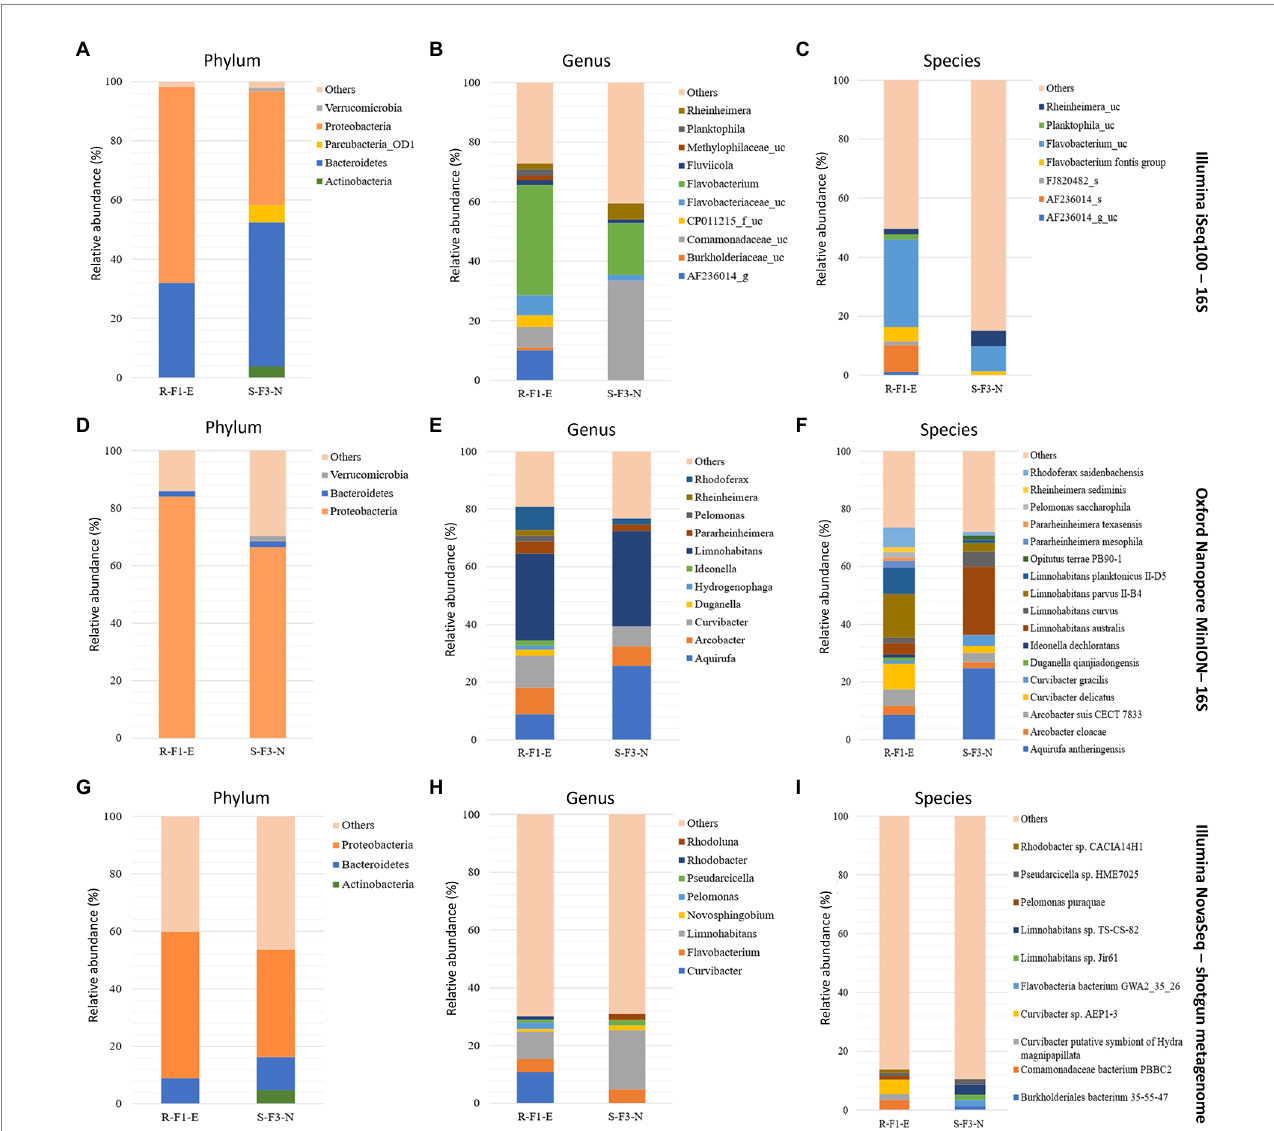
FIGURE 2 Comparison of sample R-F1-E and S-F3-N sequenced using Illumina iSeq100 (short amplicon reads), Oxford Nanopore MinION (long amplicon reads), and Illumina NovaSeq (shotgun reads) for the classification of phylum ( A , D , and G , respectively), genus ( B , E , and H , respectively), and species ( C , F , and I , respectively) with relative abundance > 1%. “Others” in the plots represents reads classified with < 1% relative abundance and reads that remains